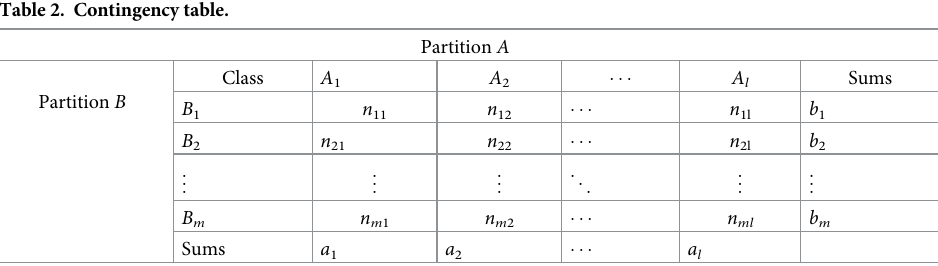
Table 2. Contingency